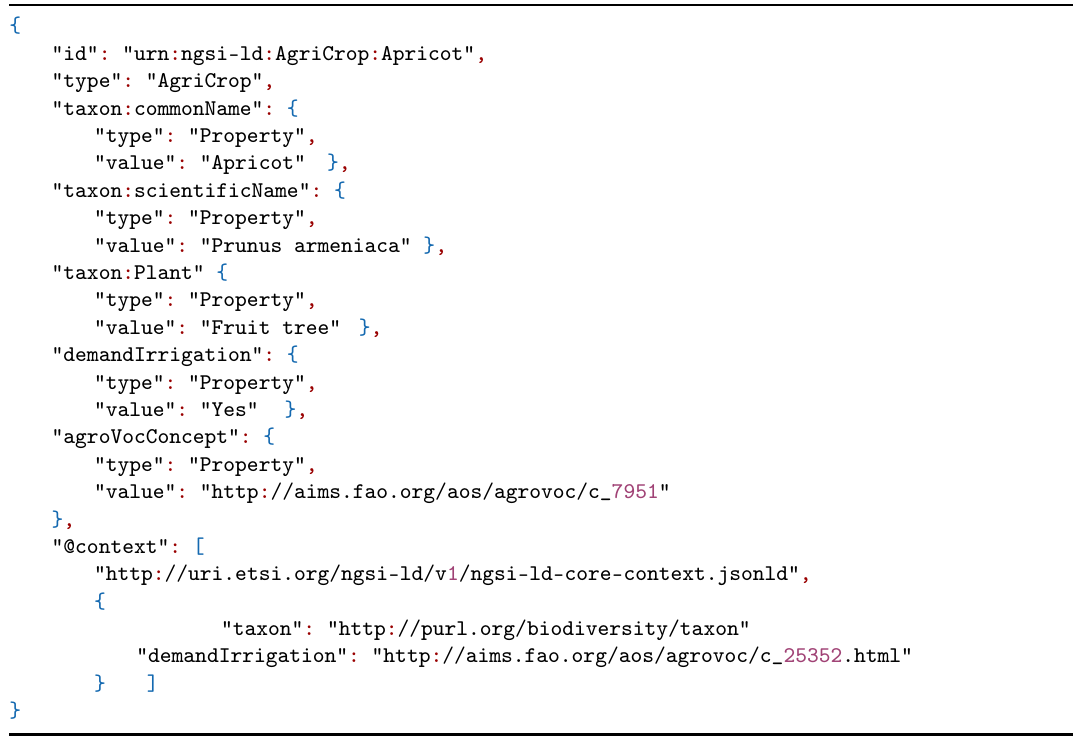
Listing 2. NGSI-LD example representing an AgriCrop